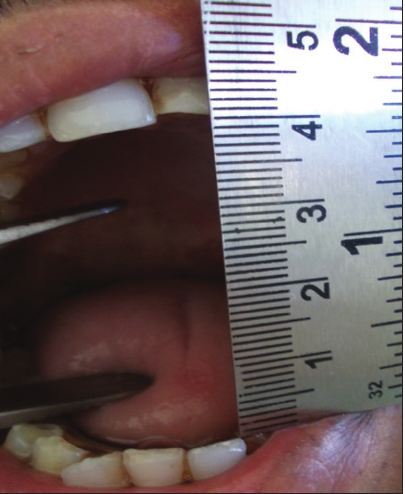
Figure 6: Postoperative mouth opening after 18